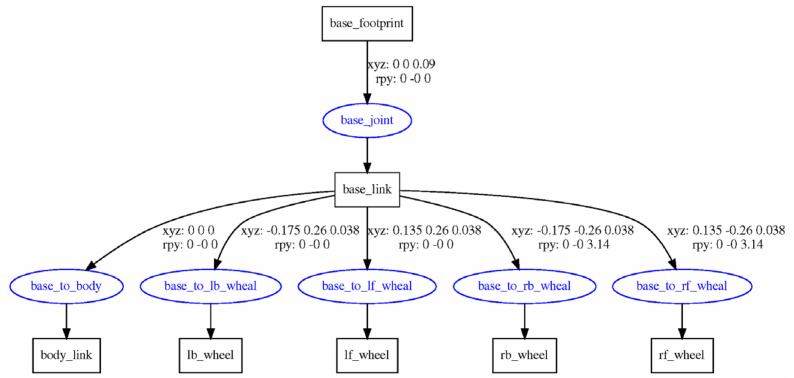
Figure 9. <joint> and <link> relationship